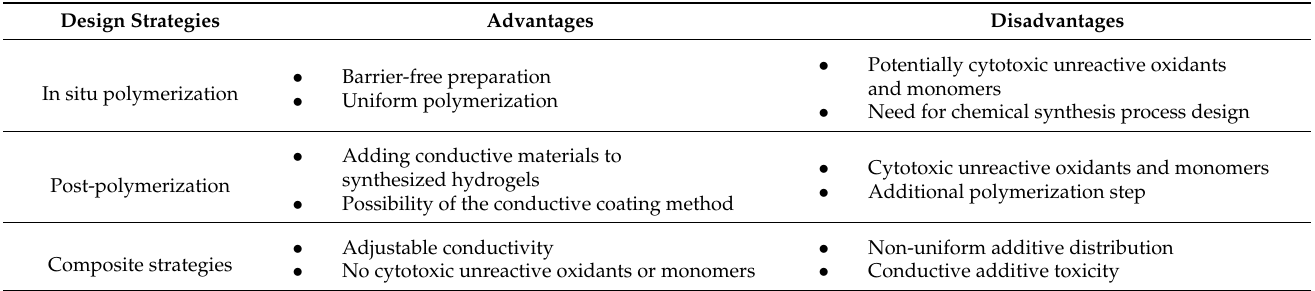
Table 4. Advantages and disadvantages of different design strategies for preparing conductive hydrogels (copied from Reference